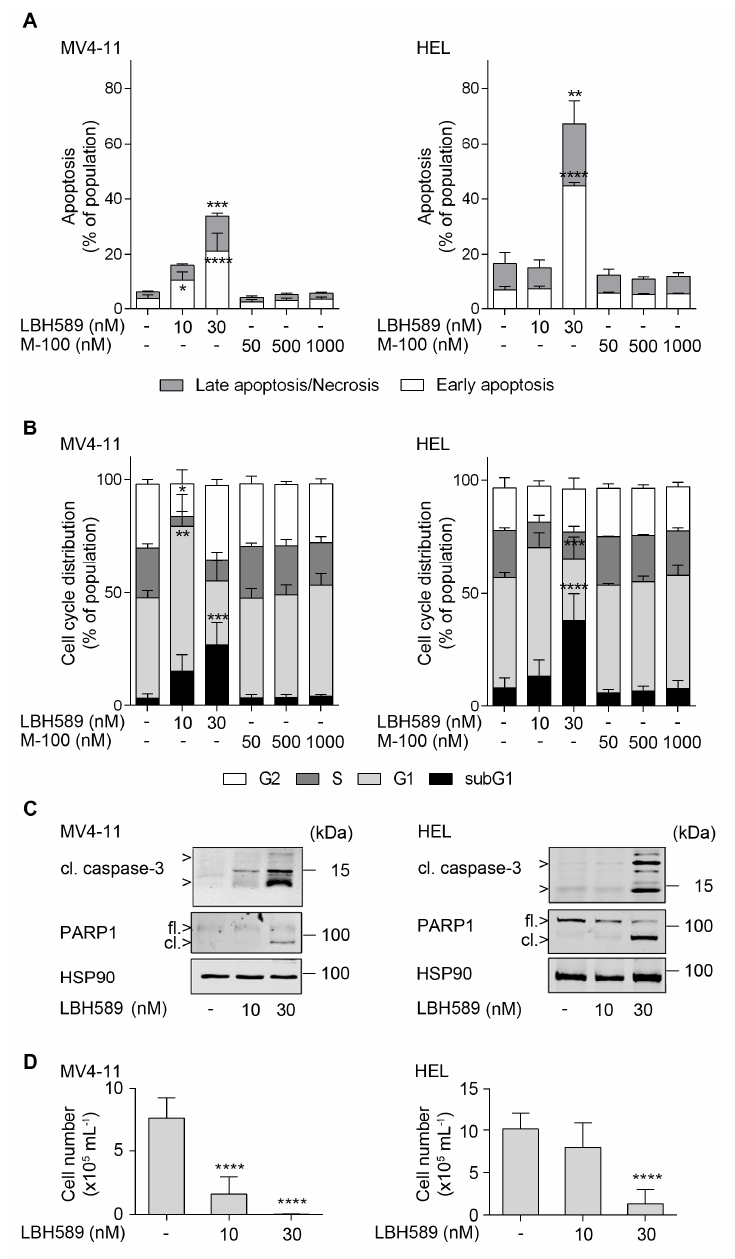
Figure 1. Human leukemia cell lines are sensitive against LBH589. ( A ) Human MV4-11 and HEL cells were treated with 10 to 30 nM LBH589 or increasing doses of marbostat-100 (M-100; 50 nM, 500 nM, and 1 µ M) for 24 h. Cells were stained with annexin-V-FITC / propidium iodide (PI) and analyzed by flow cytometry ( n = 3; mean + SD; two-way ANOVA; * p ≤ 0.05; ** p ≤ 0.01; *** p ≤ 0.001; **** p ≤ 0.0001). ( B ) Cells were incubated with HDACi as stated in ( A ). Fixed cells were stained with PI and cell cycle distributions were analyzed by flow cytometry ( n = 3; mean + SD; two-way ANOVA; * p ≤ 0.05; ** p ≤ 0.01; *** p ≤ 0.001; **** p ≤ 0.0001). ( C ) Cells were treated with 10 nM or 30 nM LBH589 for 24 h. Indicated proteins were detected via Western blot (cl., cleaved; fl., full-length) with HSP90 and β -actin as loading controls ( n = 3). Please note that compared to HEL cells MV4-11 cells have far less full-length PARP1 and that the lot of the anti-PARP1 antibody may have preferentially recognized the cleaved form of PARP1. ( D ) Regrowth of the human leukemia cell lines MV4-11 and HEL. Cells were treated with 10 nM or 30 nM LBH589 for 24 h. Thereafter, cells were washed twice with PBS and reseeded. Cells were stained with trypan blue and viable cells were counted after 4 days ( n = 3; mean + SD; one-way ANOVA; **** p ≤